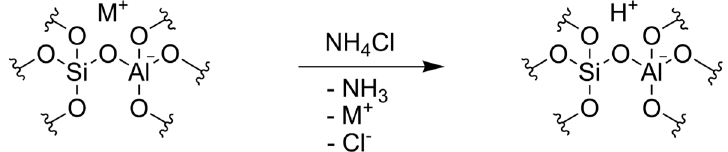
Figure 6. Ion exchange with ammonium chloride, generating Brønsted acid sites in the Al enriched biosilica after ammonia removal.